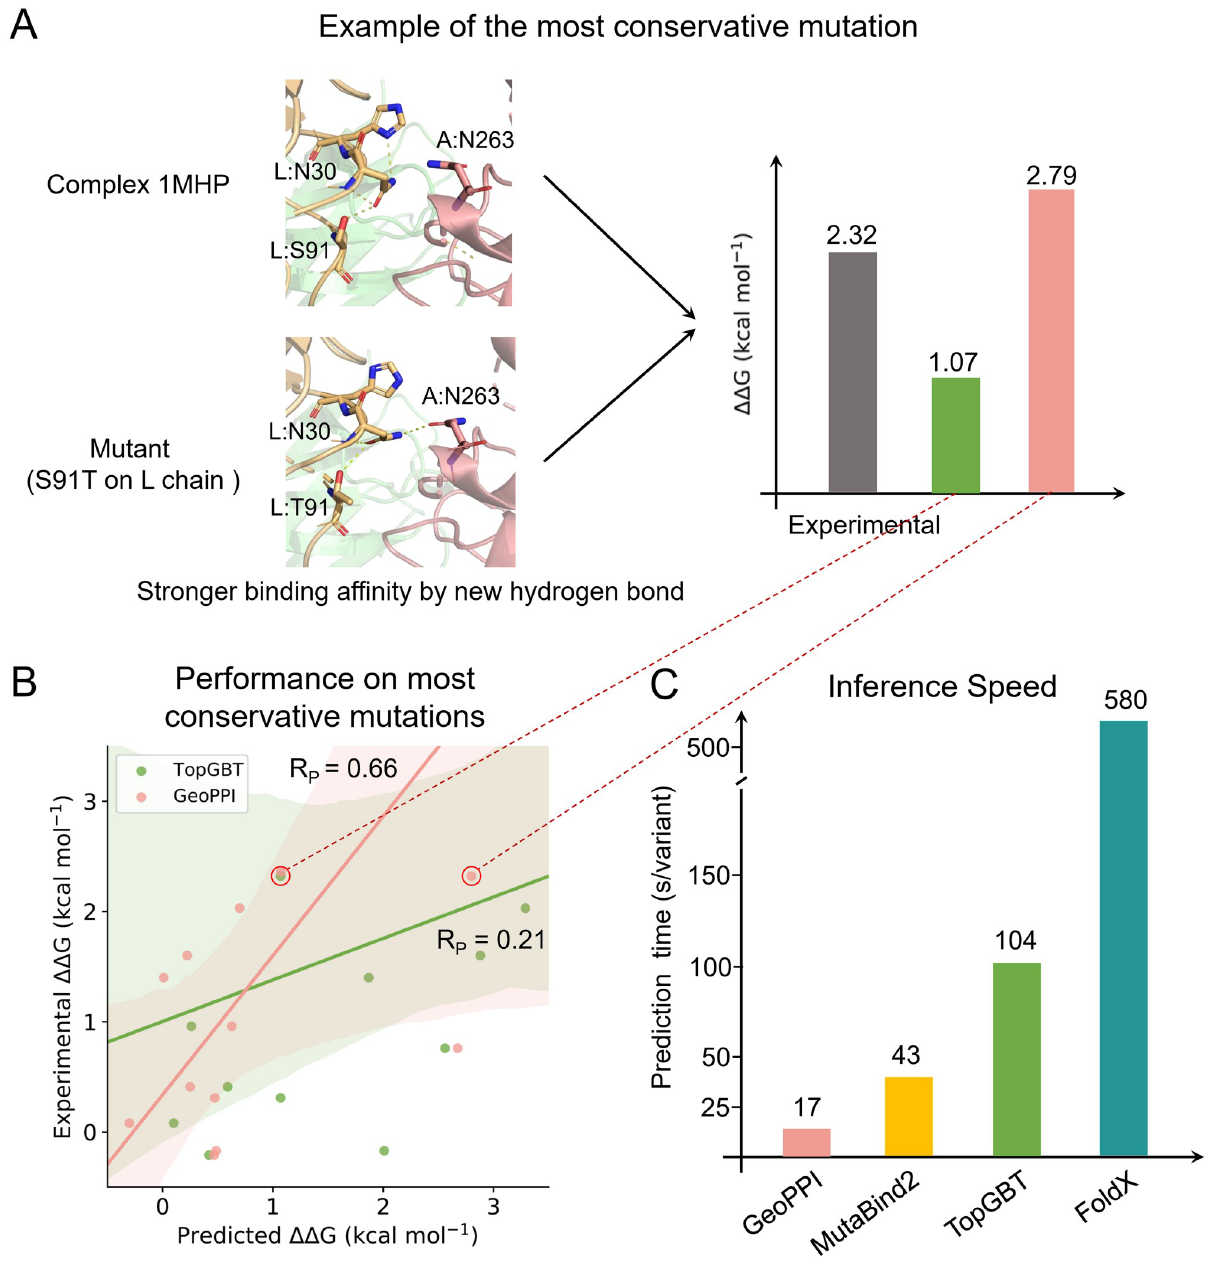
Fig 4. Comparison of GeoPPI with the baseline methods in terms of prediction performance and computational speed. (A) An example of the most conservative mutation and the predicted binding affinity changes by GeoPPI and TopGBT. (B) Prediction performance of GeoPPI and TopGBT on a subset consisting of the most conservative mutations in the S645 dataset. (C) Computational time (second/sample) needed for the prediction of individual